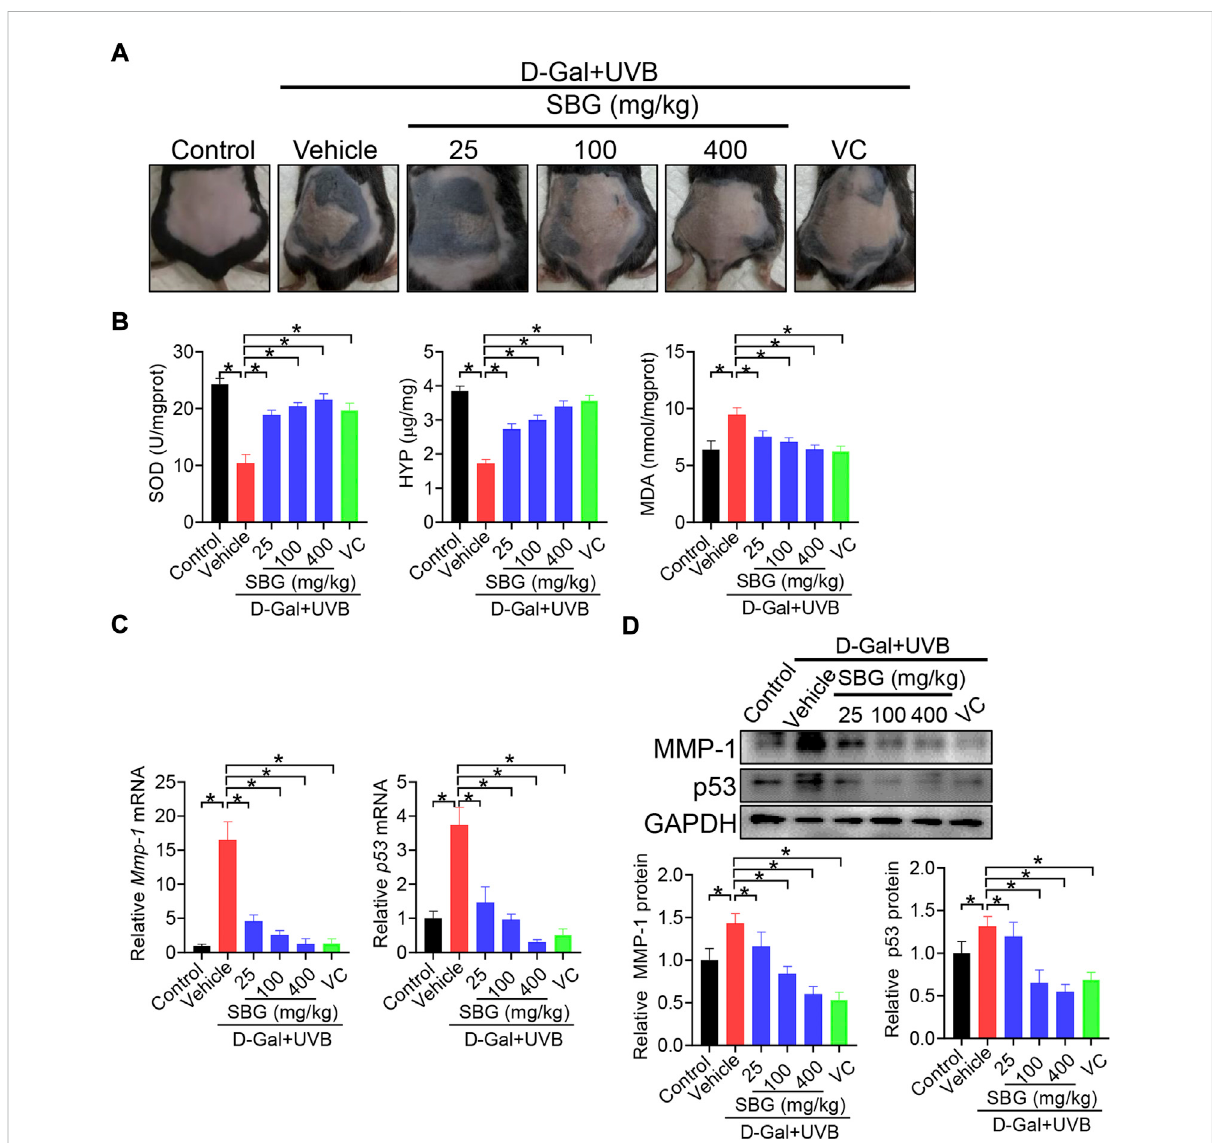
FIGURE 2 SBG protects against skin aging induced by D-gal/UVB in mice. (A) Surface examination of dorsal skin derived from D-gal/UVB-treated and controlmice. (B) SkinSODactivityandHYP/MDAlevelsinD-gal/UVB-treatedandcontrolmice. (C) mRNAexpressionof Mmp-1 and p53 intheskinof D-gal/UVB-treated and control mice. (D) Protein expression (top panel) and quanti fi cation (bottom panel) of MMP-1/p53 in the skin of D-gal/UVB- treated and control mice. In panels B – D, data are mean ± SD ( n = 7). * p < 0.05 (one-way ANOVA and Bonferroni post hoc test). VC,